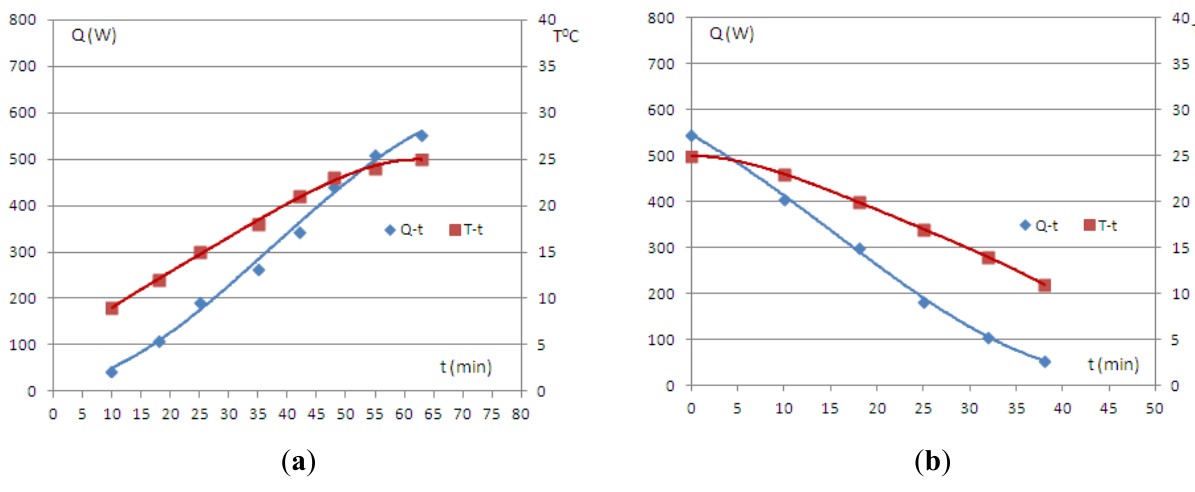
Figure 6. Solar global irradiance and the variation of temperature with air